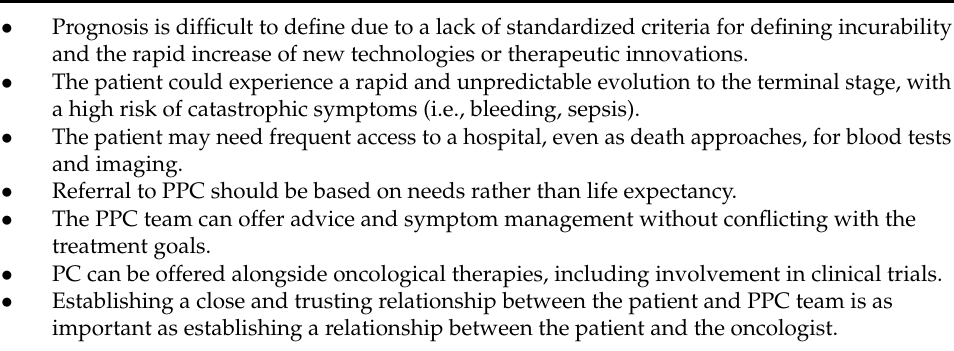
Table 3. Considerations for PPC providers and oncologists to properly implement the “integrated care